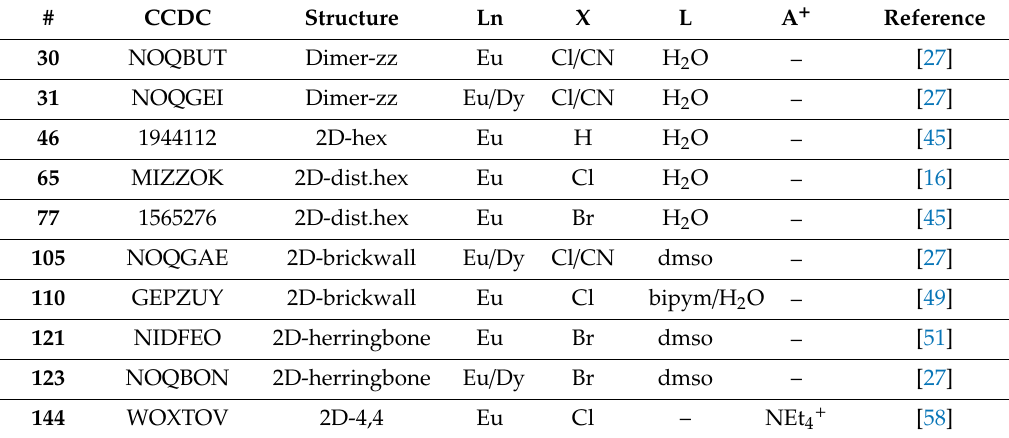
Table 19. Structurally characterized Eu(III) compounds with anilato ligands.